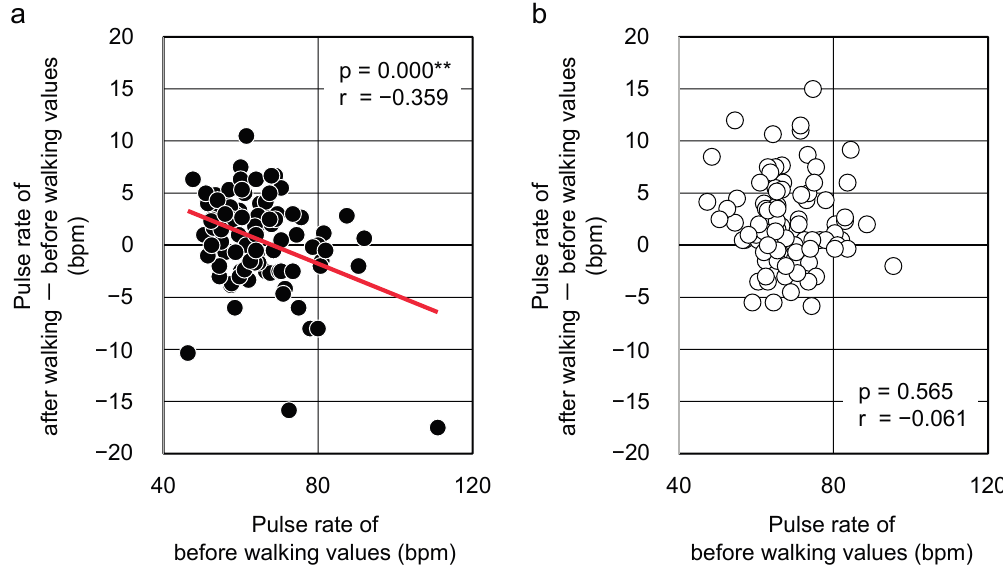
Figure 4. The relationship between the “initial value” and the “changes after walking” in a forested area ( a ) and urban area ( b ) with respect to pulse rate (n = 92). ** p < 0.01 by Pearson correlation